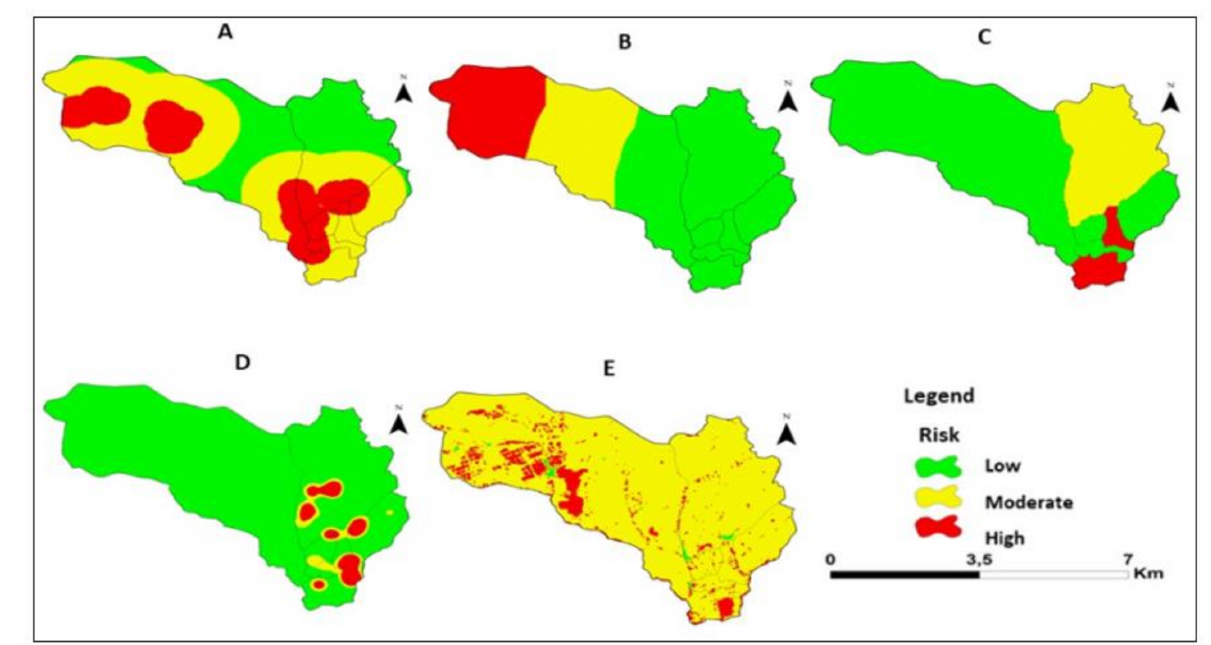
Figure 8. Risk for malaria. ( A ). Temperature. B) Precipitation. ( C ). Altitude. ( D ). Slope. ( E ). LULC for Sussundenga Village.